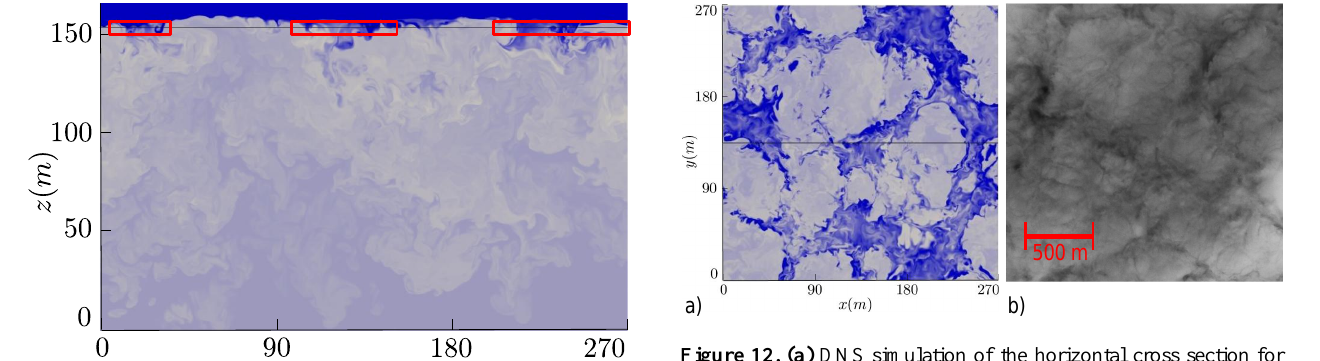
Figure 12. (a) DNS simulation of the horizontal cross section for cloud liquid water content. The simulated aircraft trajectory is given by the black line and the scaling of the color code is the same as in Fig. 11. (b) Photograph, taken by a camera mounted at the fuselage of the POLAR 5 aircraft showing the top of the boundary layer cloud deck which was observed during Flight 11. The scales of (a) and (b) are different but the self-similarity of the structures is demonstrated qualitatively for the cloud encountered in the real atmosphere and the simulated cloud liquid water